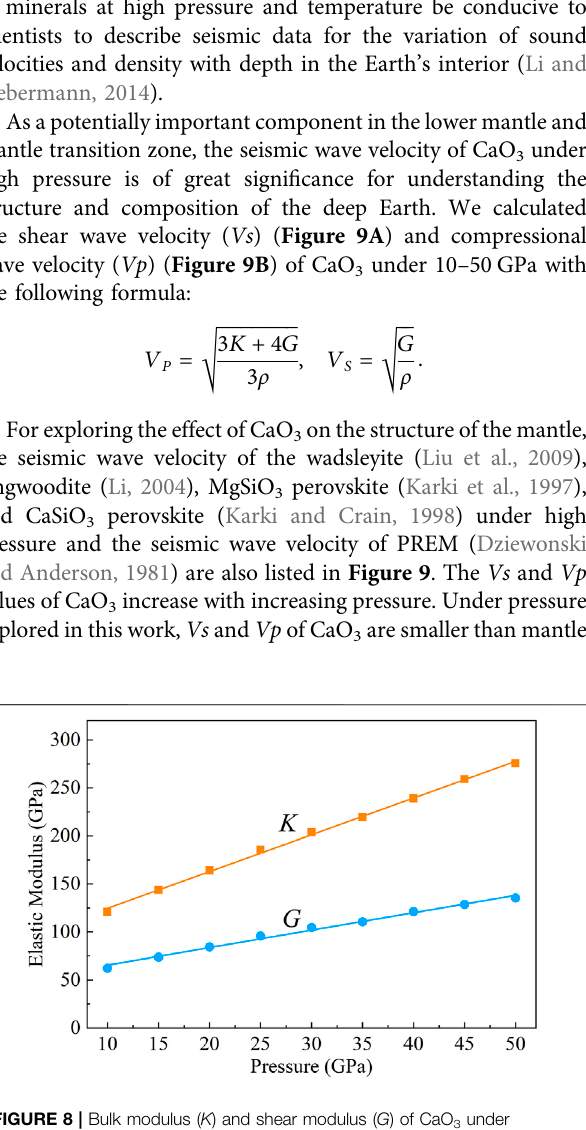
FIGURE 8 | Bulk modulus ( K ) and shear modulus ( G ) of CaO 3 under 10 – 50 GPa.Theorangesquaresrepresentbulkmodulus,andthebluecircles represent shear